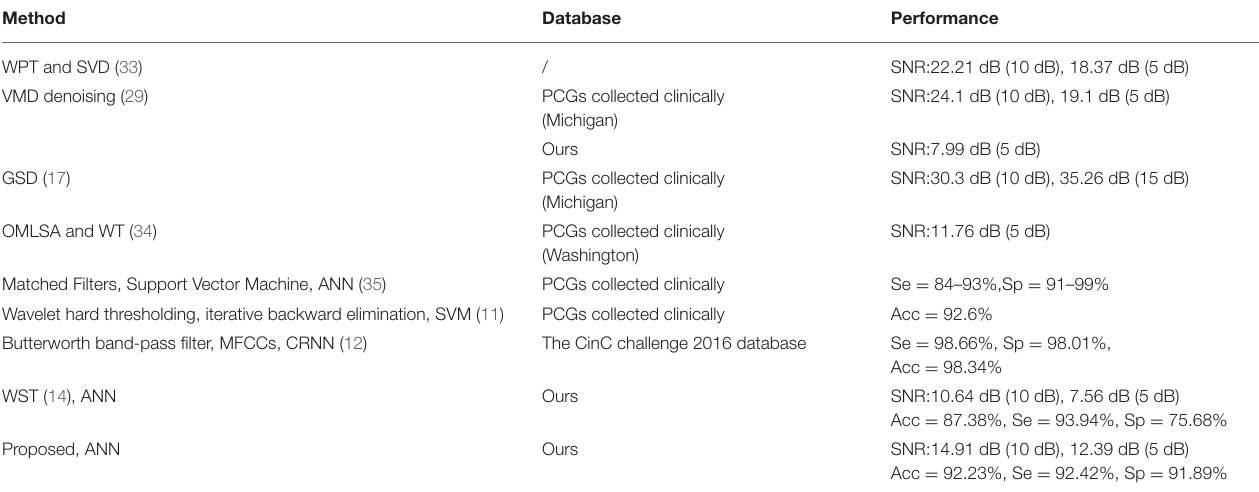
TABLE 5 | Comparison of performance with other